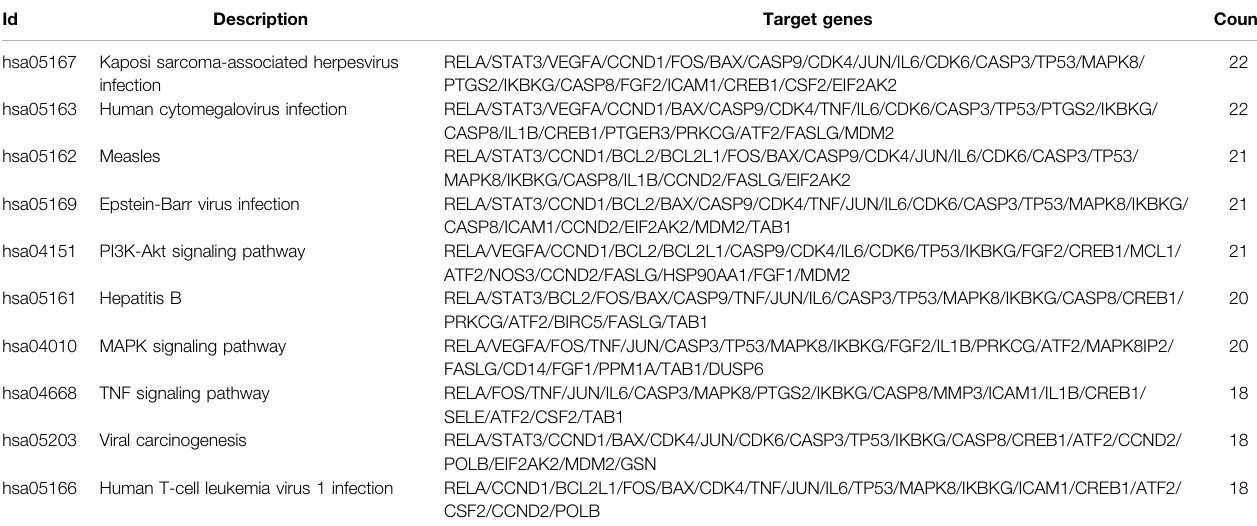
TABLE 3 | Target genes involved in top KEGG